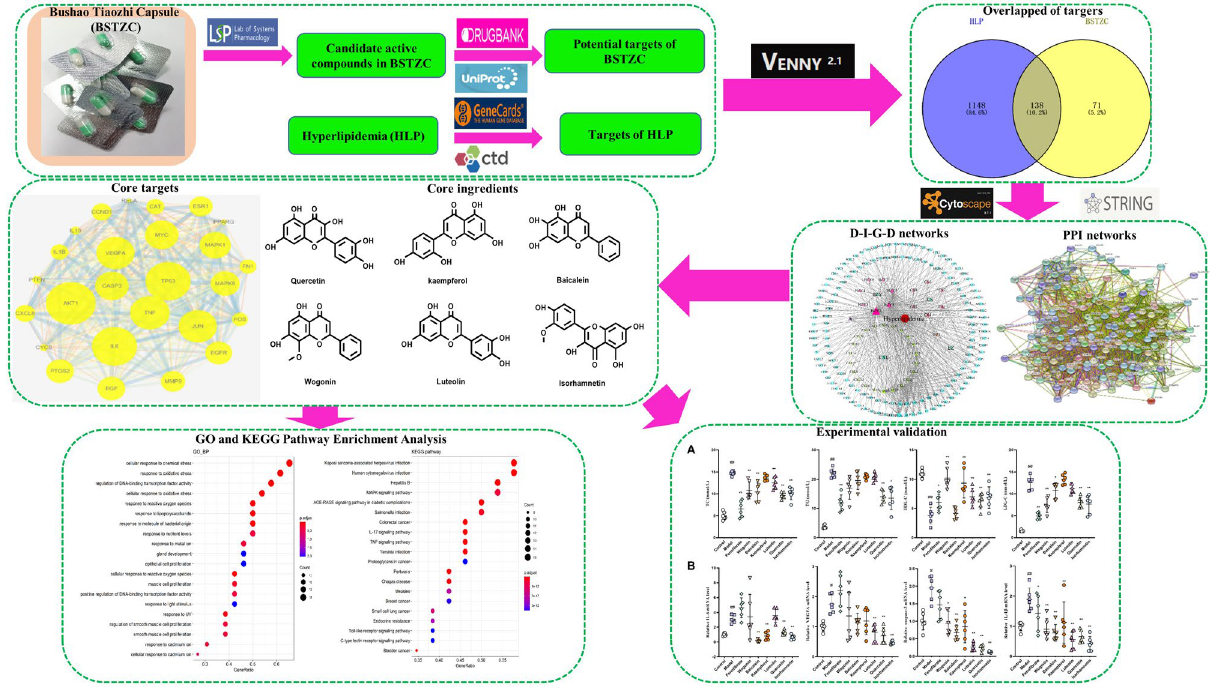
Figure 1. Workflow diagram of the network pharmacology-based analysis of BSTZC in the treatment of